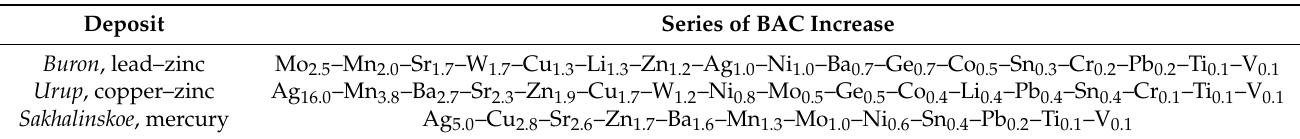
Table 2. Biological absorption coefficients (BACs) of the chemical elements in the ash of woody plants from the ore fields of the North Caucasus geochemical province. Deposit Series of BAC Increase Buron ,